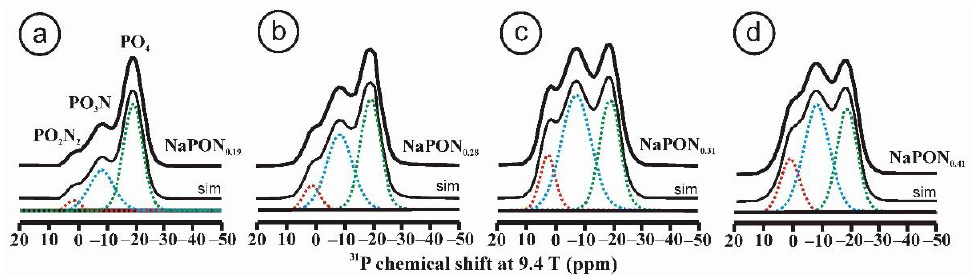
Figure 2. 31 P MAS NMR spectra of NaPON glasses with increasing nitrogen contents: N/P = 0.19, 0.28, 031, 0.41, respectively (see Table 2 for the deconvolutions). Spectra were deconvoluted into three Gaussian-like curves attributed to resonances of PO 4 , PO 3 N and PO 2 N 2 structural units. Adapted with permission from Ref. [34]. 2021, American Chemical Society. ( a ) NaPON 0.19 , ( b ) NaPON 0.28 , ( c ) NaPON 0.31 and ( d ) NaPON 0.41 . Table 2. The numerical values of the deconvolutions of the 31 P MAS NMR spectra of Figure 2. Glasses NaPON 0.19 NaPON 0.28 NaPON 0.31 NaPON 0.41